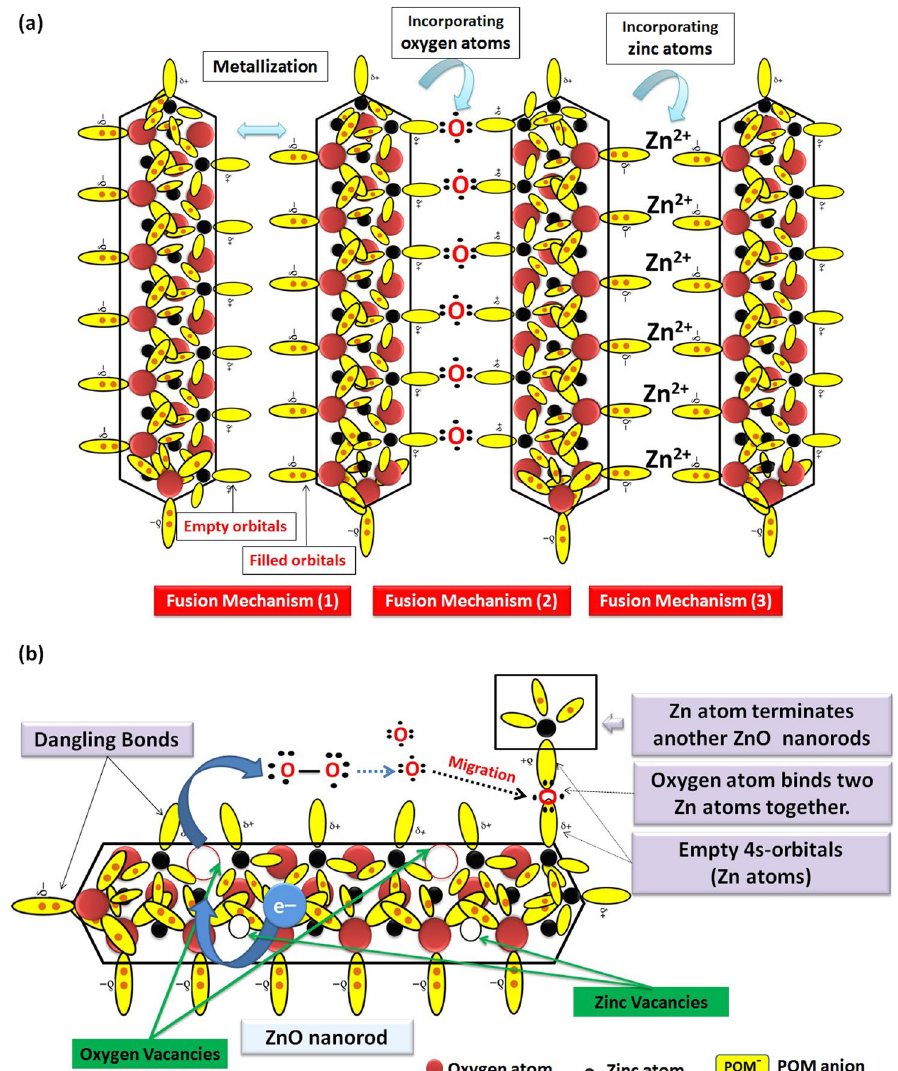
Figure 13. Schematic illustration for the three possible fusion mechanisms of ZnO nanorods in PMA solution ( a ), and schematic illustration for catalyzing the O-O bond cleavage of O 2 molecules by electron transferred from lattice oxygen atoms to vacancies to the O 2 molecule ( b